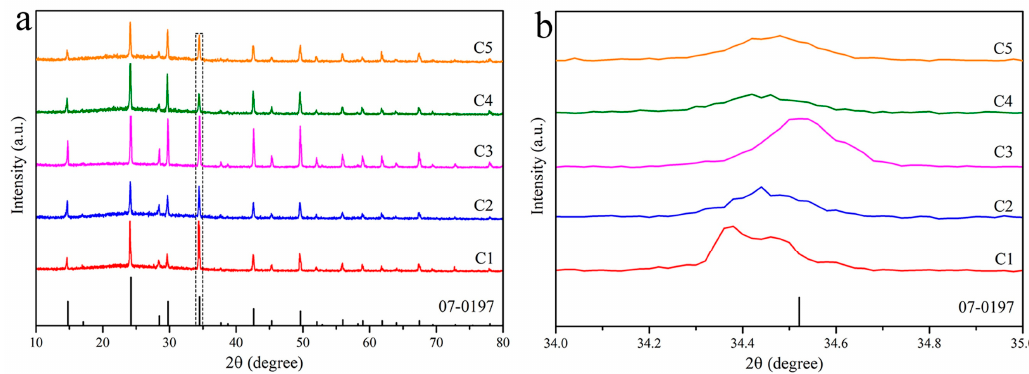
Figure 9. ( a ) The XRD patterns of Cs 2 SnCl 6 crystals doped with di ff erent concentration of Ce; ( b ) the Figure 9. (a) The XRD patterns of Cs 2 SnCl 6 crystals doped with different concentration of Ce; ( b ) the zoom in view in the range of 34–35 ◦ zoom in view in the range of 34-35 o .